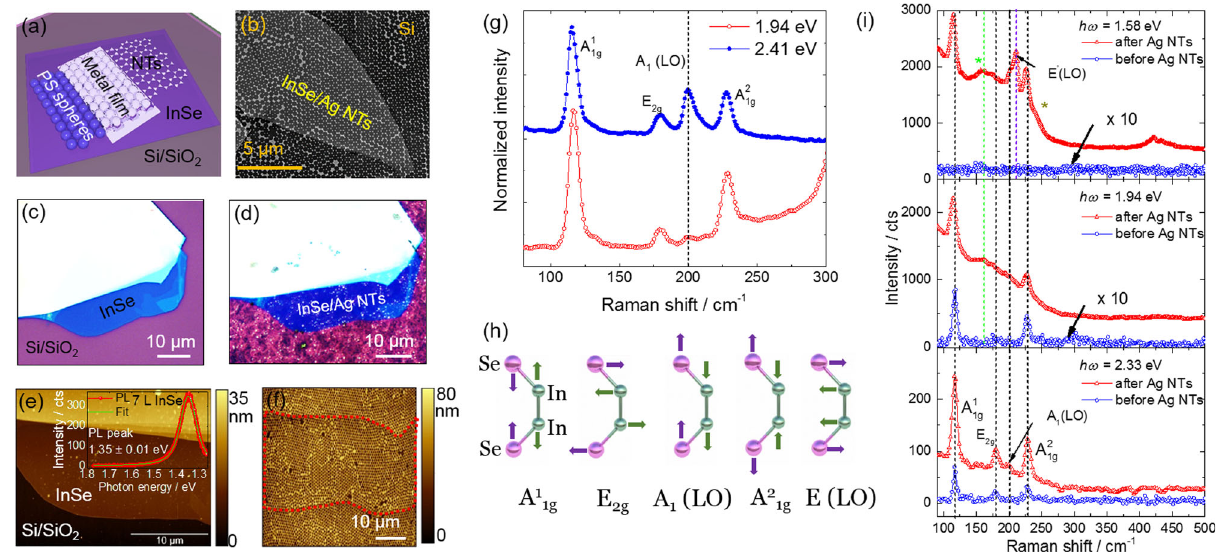
Fig. 1 Optical and morphological characterization of InSe samples. a Schematic representation of the sample preparation. Polystyrene spheres of 400nm size were used for nanosphere lithography (NSL). Ag, Au, and Al were used for nanotriangles (NTs) formation. b A typical scanning electron microscope (SEM) image of the InSe sample after Ag NT deposition. Silicon with native oxide was used as substrate for SEM to avoid charging effects. c , d Optical images and e , f atomic force microscope (AFM) topographies of one typical InSe sample with different thicknesses before and after NSL with Ag, respectively. Inset of ( e ) displays the photoluminescence spectra of 7 layer (7 L) InSe with a Voigt fi tting. The red dashed lines in ( f ) marks the area of the thin fl ake as shown in the optical images. g Resonant and nonresonant Raman spectra acquired with 2.41 and 1.94 eV, respectively, of 7L InSe. Acquisition time for the Raman measurements were 10s × 2 and 30 s × 10, respectively, and the laser power in both measurements were ~100 μ W. h Elongation patterns of the phonon vibrations visible in the Raman spectra. i Raman spectra of 7 L InSe before and after NSL with Ag acquired with 1.58, 1.94, and 2.33 eV excitations. The broad spectral feature between 150 and 190cm − 1 is due to the presence of E 2g , and contribution of In 2 O 3 (green dashed line and asterisk). The gray asterisk indicates a feature assigned to amorphous Se. Acquisition time for the measurements were 5s ×2 and the laser power was 10 μ